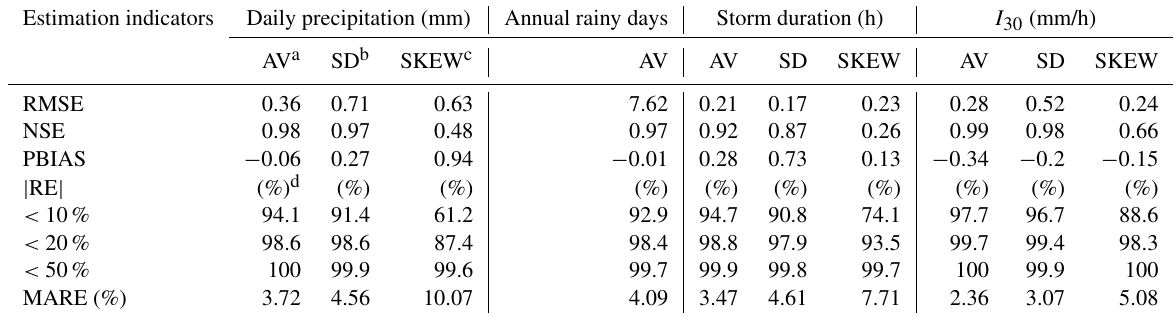
Table 5. Comparison of CLIGEN-generated daily rainfall and annual rainy days based on observed input parameters and UK-interpolated ones.